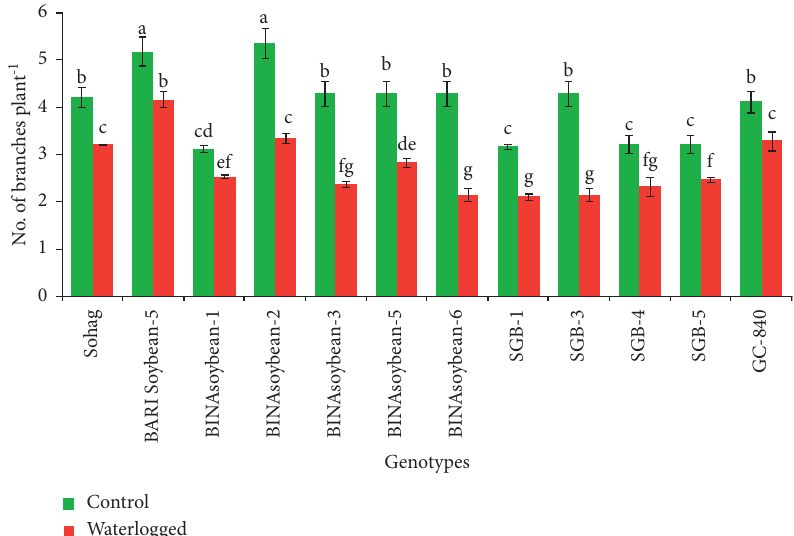
Figure 2: Effect of waterlogging stress on number of branches plant − 1 of different soybean genotypes. For each treatment, the mean ( ± SD) was determined from three replicates. Different alphabets on the bars indicate significant difference at P ≤ 0 . 05 after mean comparison by Fisher’s LSD